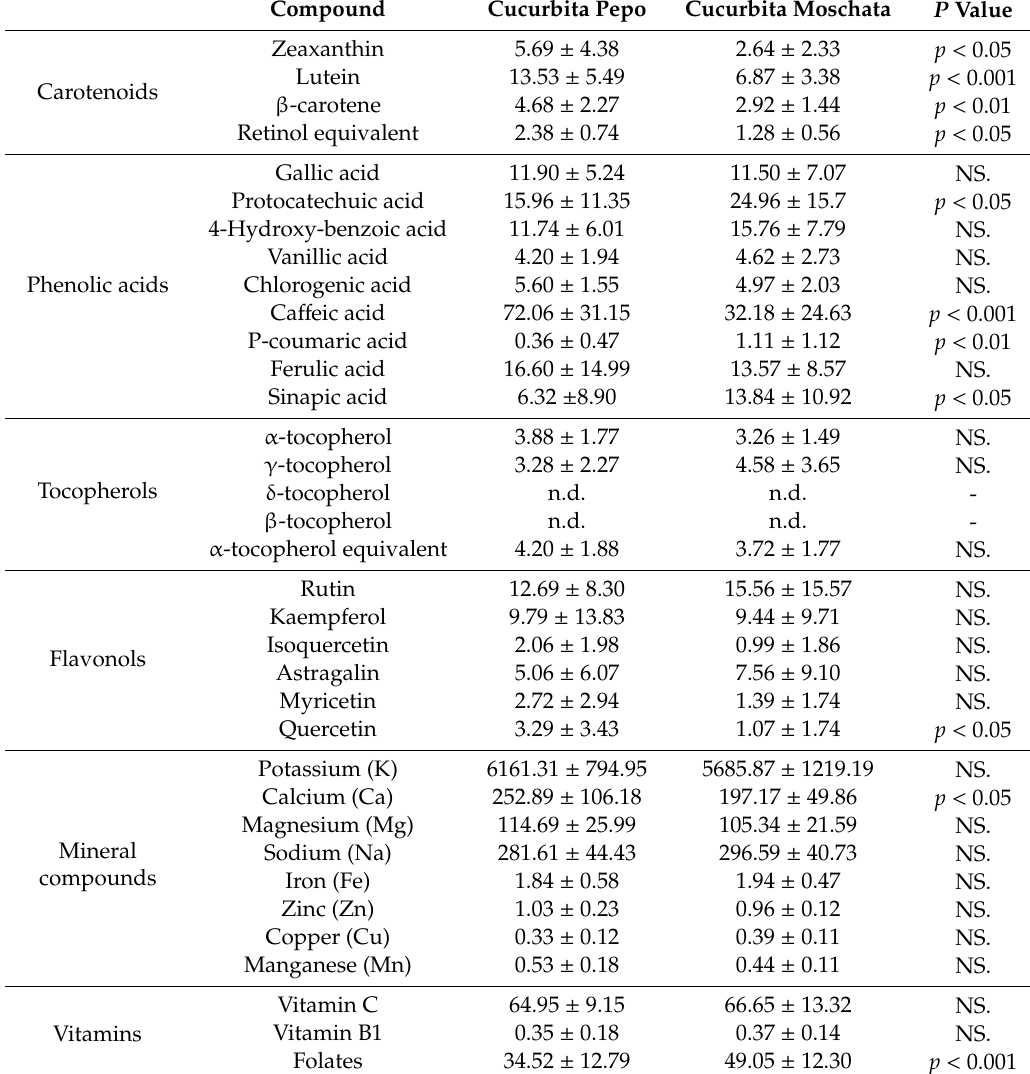
Table 6. Comparison of the bioactive compounds content between two pumpkin species.